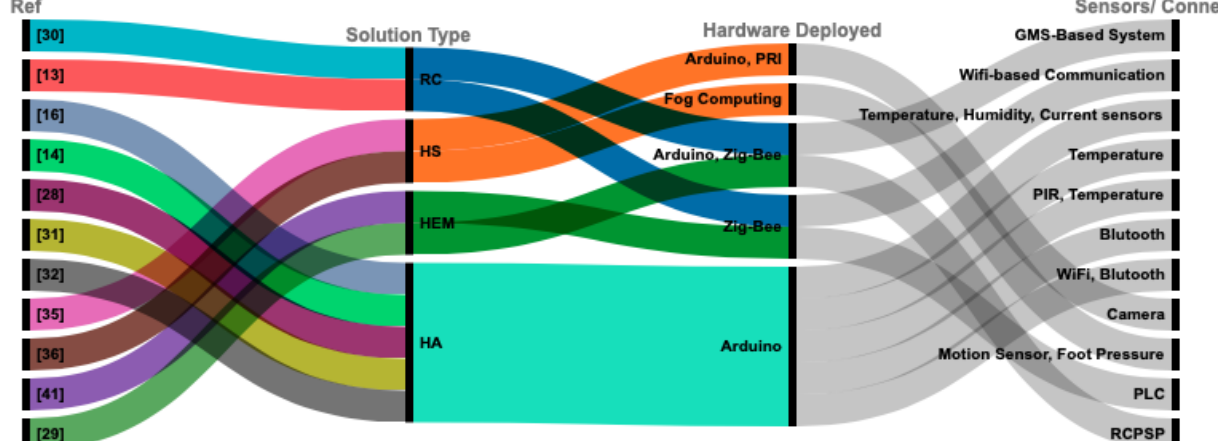
Figure 1. A summary of different smart home solutions including remote controlling (RC), home security (HS), home energy management (HEM) and home automation (HA).